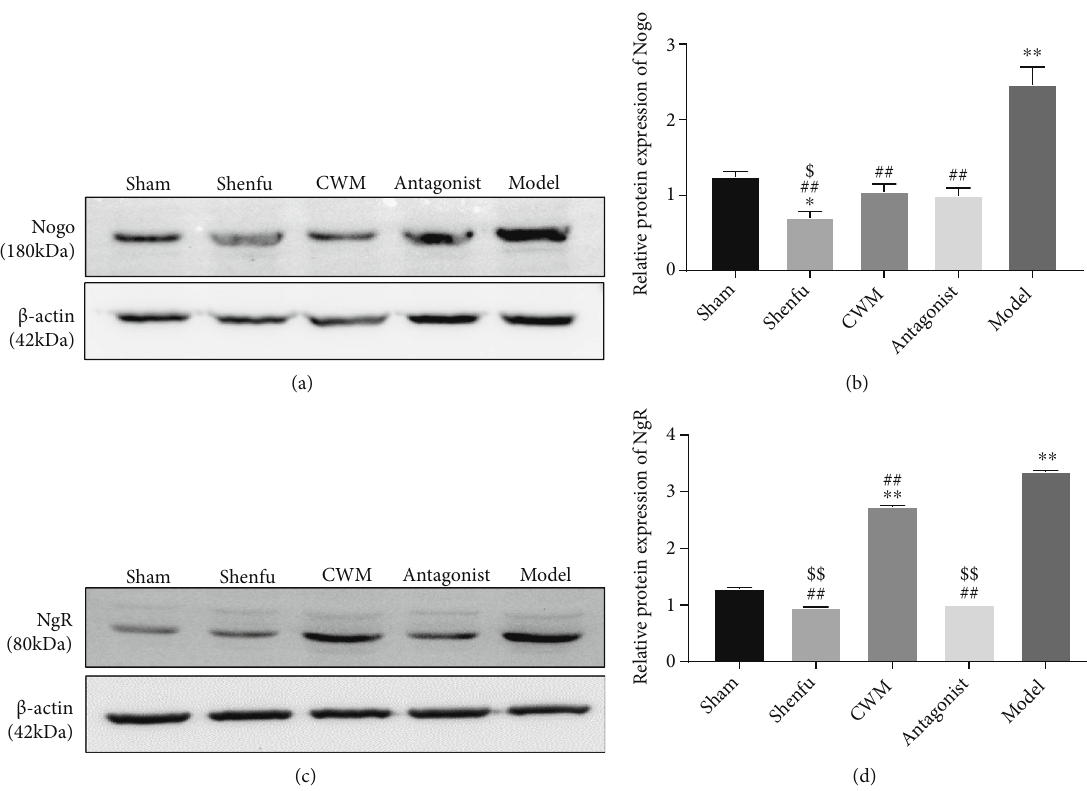
Figure 4: Western blotting detection of Nogo and NgR protein expression in each group at 3d after return of spontaneous circulation (ROSC). (a) Western blots of Nogo in hippocampal tissues of each group. (b) Nogo protein expression analyzed in hippocampal tissues of each group. (c) Western blots of NgR in hippocampal tissues of each group. (d) NgR protein expression analyzed in hippocampal tissues of each group. Compared with the Sham group, * P < 0 : 05 , ** P < 0 : 01 ; compared with the model, ## P < 0 : 01 ; compared with the CWM, $ P < 0 : 05 , $$ P < 0 : 001 . n = 3 in each subgroup at di ff erent